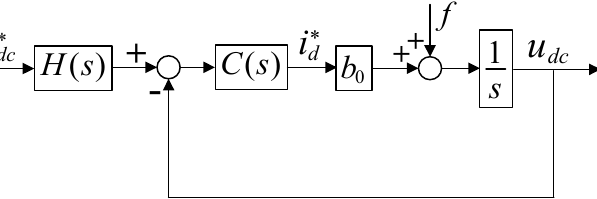
Figure 8. 2dof closed-loop diagram of modified LADRC-based voltage control system.